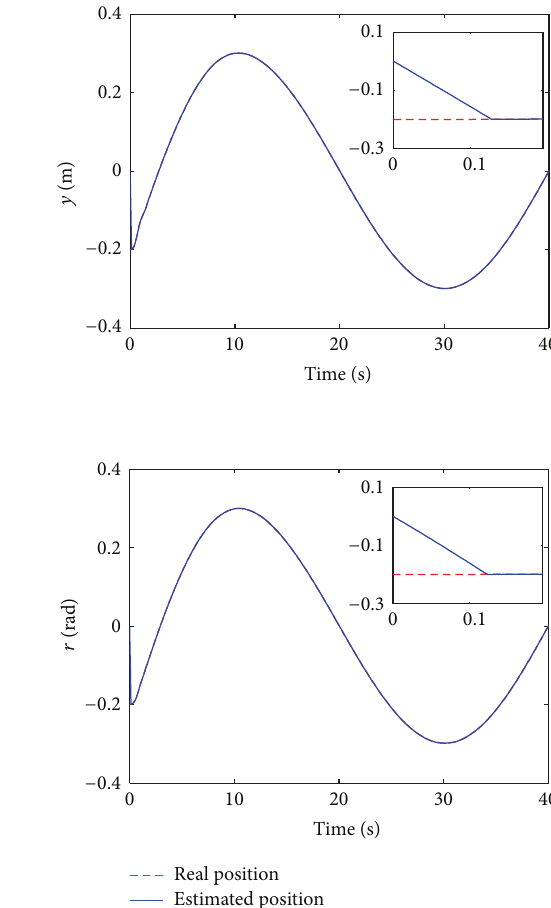
Figure 2: Estimated position and real position of output feedback